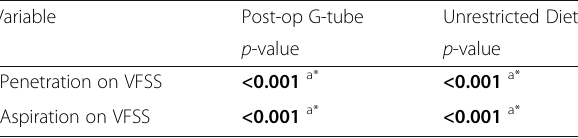
Table 6 Early VFSS as predictor for long-term functional outcomes.